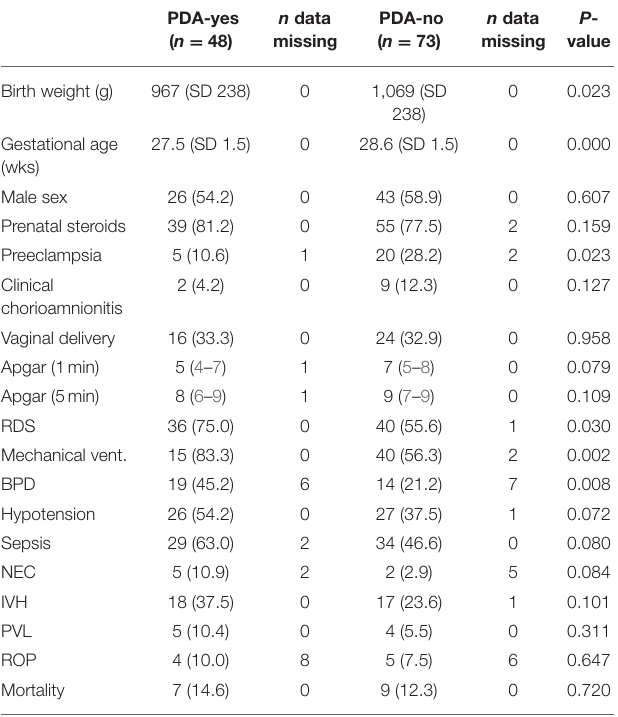
TABLE 1 | Baseline characteristics and neonatal complications in preterm infants with and without PDA.